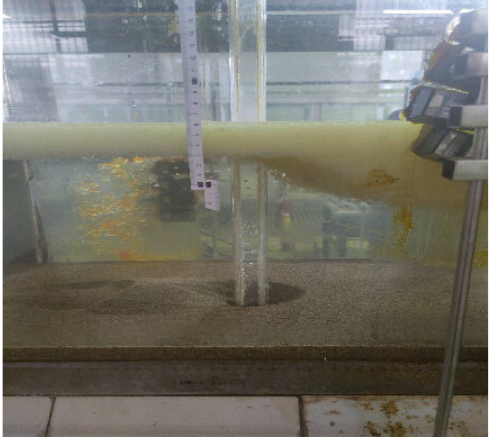
Figure 4. Local scour hole around a pier.